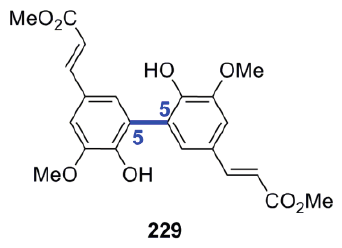
Figure 19. The structure of 5-5 coupled dimethyl dehydrodiferulates ( 229